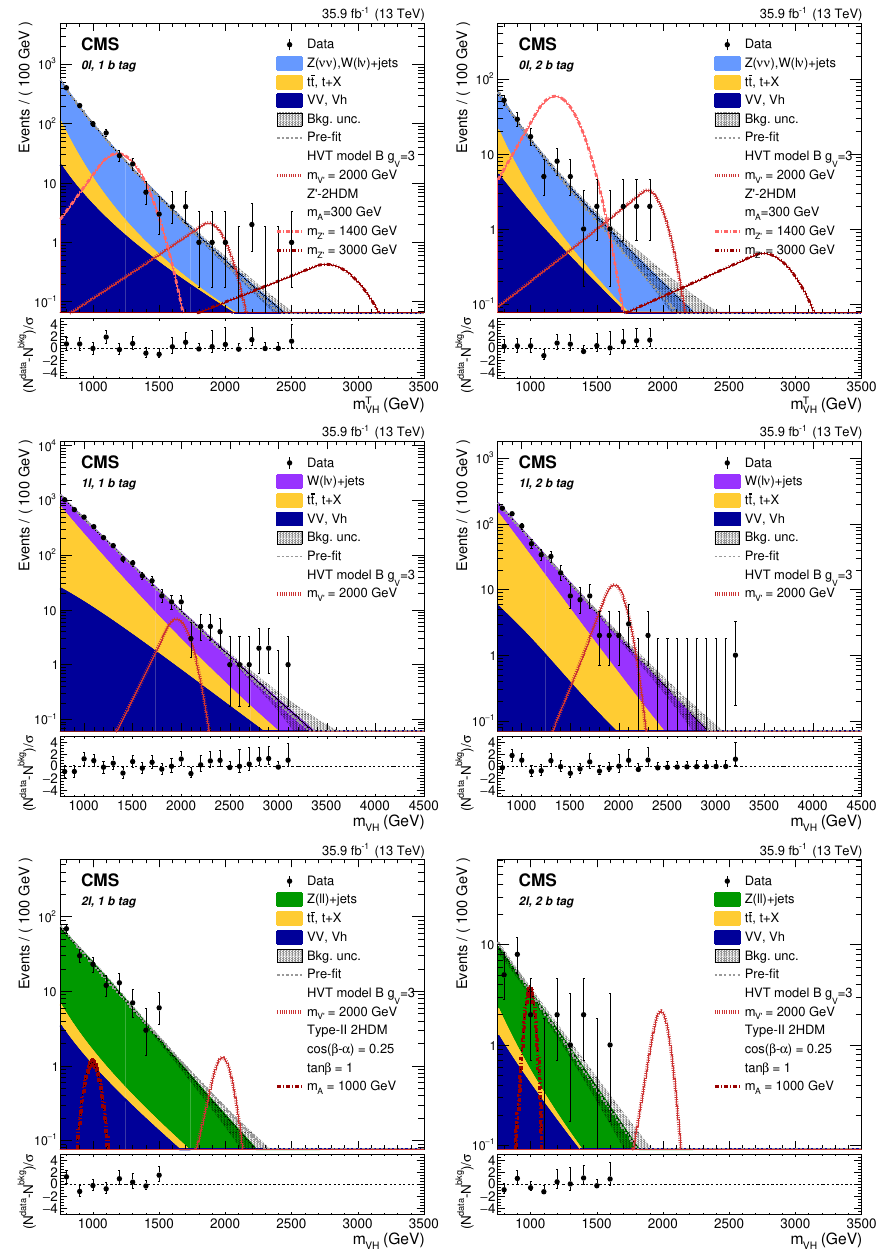
Figure 4 . Resonance transverse mass m T distributions in the 0 ‘ category (upper) and candidate Vh mass m Vh in the 1 ‘ (middle), and 2 ‘ (lower) categories, and separately for the 1 (left) and 2 (right) b-tagged subjet selections. Electron and muon categories are merged together. The expected background events are shown as (cid:12)lled areas, and the shaded band represents the total background uncertainty. The observed data are indicated by black markers, and the potential contribution of a resonance produced in the context of the HVT model B with g V = 3, or a Z 0 -2HDM signal with m A = 300 GeV, m (cid:31) = 100 GeV, and g Z 0 = 0 : 8, are shown as dotted red lines. The bottom panels depict the pulls in each bin, ( N data N bkg ) =(cid:27) , where (cid:27) is the statistical uncertainty in data, as (cid:0) given by the Garwood interval